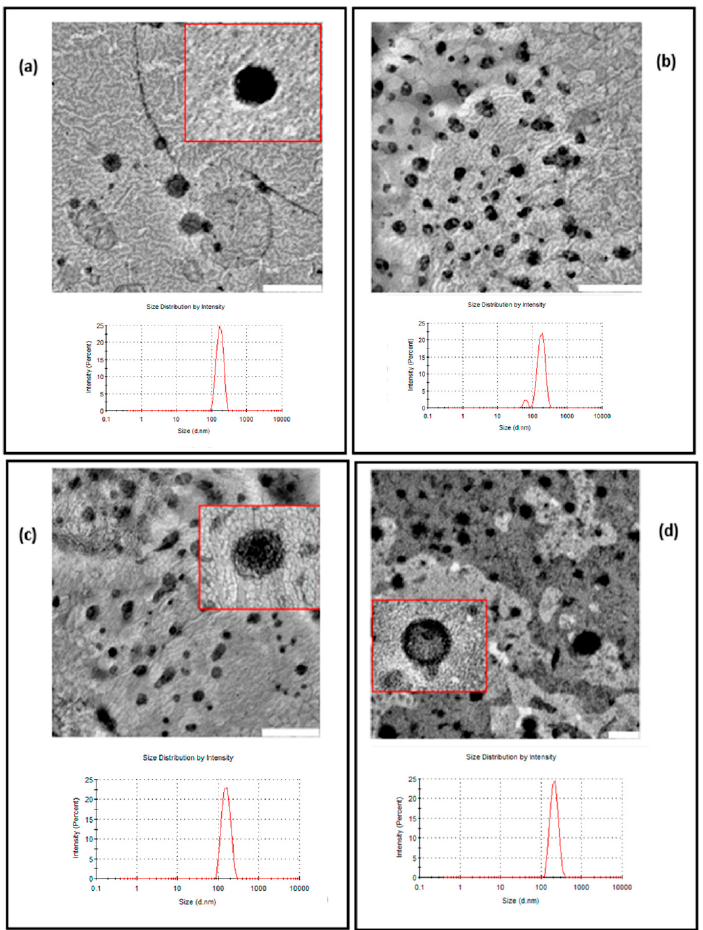
Figure 5. Transmission electron micrographs (TEMs) of samples and size distribution by DLS: ( a ) Empty-L; ( b ) TM-L; ( c ) Acz-L; ( d ) CLL. Scale bar for the TEM images in ( a – c ): 500 nm. Scale bar for the TEM image in ( d ): 200 nm.